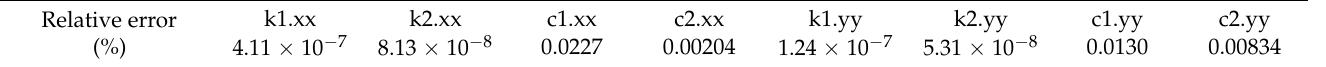
Table 13. The biggest relative identification error using the computational example g1.4.